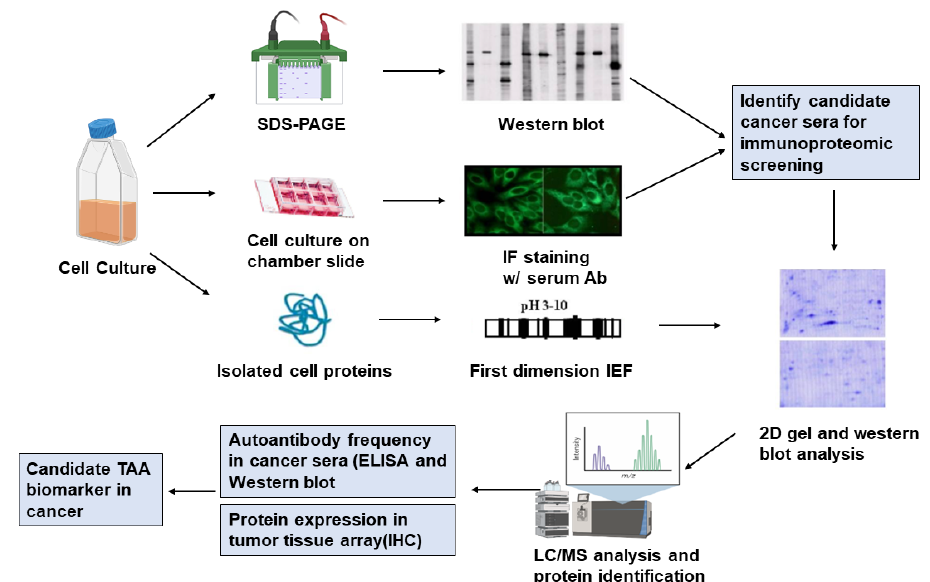
Figure 1. Using immunoproteomic approach for identification and validation of TAAs. Firstly, the sera from HCC patients with high titer fluorescently stained were selected out with western blotting analysis and indirect immunofluorescence by using cultured tissue cells as antigen. Candidates of TAA were then separated using 2D-SDS-PAGE and analyzed by mass spectrometry. Finally, multiple methods, such as enzyme-linked immunosorbent assay (ELISA), Western blotting and immunohistochemistry (IHC), and tissue arrays, are used to validate identified potential tumor-associated antigen-anti- body systems. These validated TAAs can be used to form TAA arrays for the immunodiagnosing early-stage cancers.